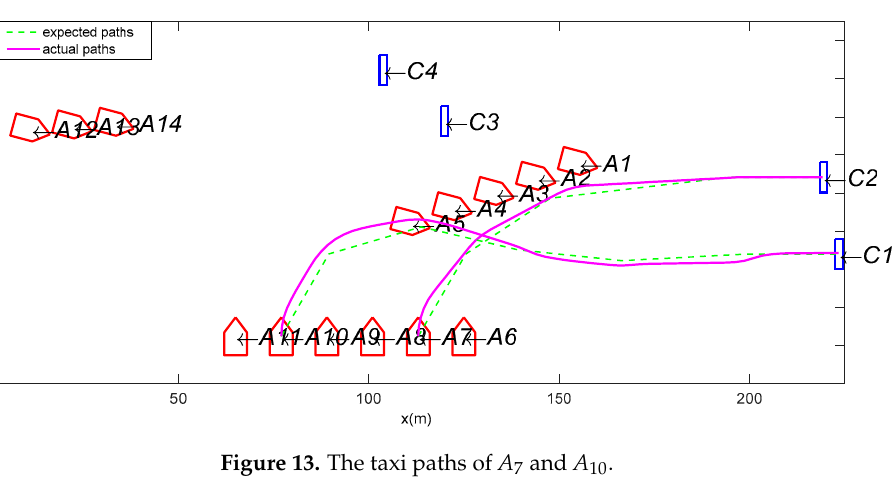
Figure 13. The taxi paths of A 7 and A 10 .